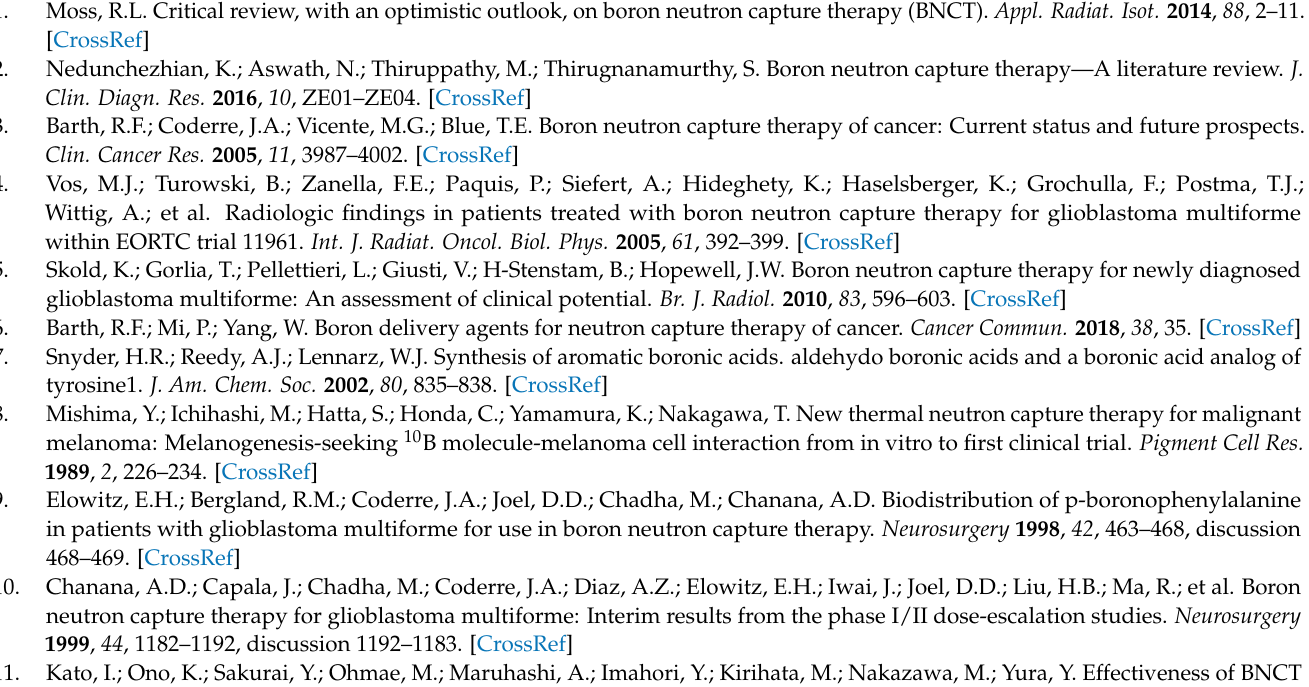
Table S2: Boron uptake in cancer cells after incubation with 4-BPA, Table S3: Statistical analysis of specific uptake between each cell after addition of 3-BPA, Table S4: Statistical analysis of specific uptake between each cell after addition of 4-BPA, Table S5: Statistical analysis of specific uptake between 3-BPA and 4-BPA in each cell, Table S6: Significant difference between 3-BPA-Fru and 4-BPA-Fru in boron accumulation in each tissue after administration into melanoma-bearing mice, Table S7: Biodistribution of boron concentration at 60 min after injection of 3-BPA, 3-BPA-Fru, and 4-BPA-Fru in T3M-4 tumor-bearing mice, Table S8: Water solubility of phenylalanine, tyrosine, and meta-tyrosine; Supplementary